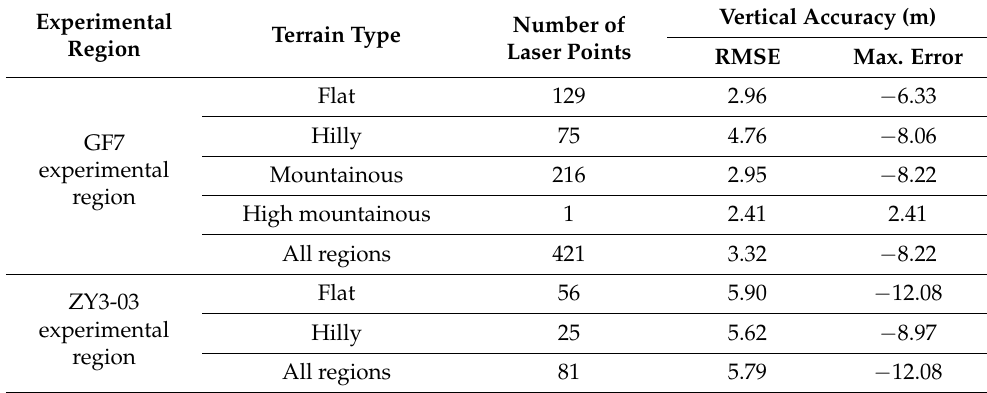
Table 4. Stereo image vertical accuracies obtained using the LAPs as check